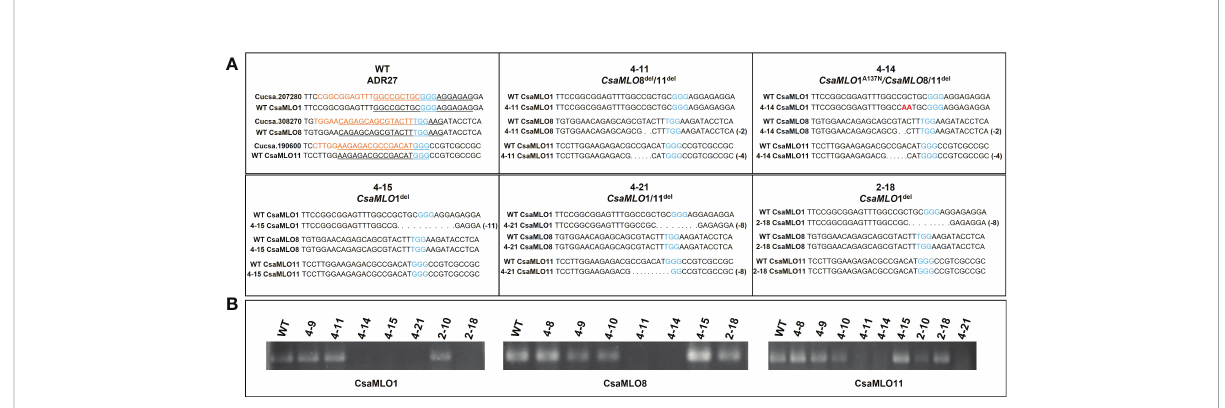
FIGURE 2 Nucleotide sequence alignment of CsaMLO s. Clade V CsaMLOs of WT-ADR27 were aligned with the reference sequence to detect any genotypic differentiation, and the underlined nucleotides on the alignment shows the PCR primers for detection of homozygous mutants; (A) the sequence results indicated that 4-11 has deletion mutations on CsaMLO8 (2 bp) and CsaMLO11 (4 bp) even if there is no mutation on the CsaMLO 1. Although 4-14 is triple mutant (2 bp del at CsaMLO 8 and 4 bp del at CsaMLO11 ), there is substitution mutation on CsaMLO 1 with 2 nucleotides change as “ AA ” rather than “ GC ” on the Cas9 cleavage site. 4-15 and 2-18 were determined as CsaMLO1 del with 11 bp and 8 bp deletions as a result of NHEJ. Also 8 bp deletions were detected on 4-21 ’ s CsaMLO1 and CsaMLO11 ; (B) The PCR products were observed to be non-mutant genotype in terms of CsaMLO . However, there was no ampli fi cation in PCR results of mutant, because of homozygous deletion or substitution on the primer binding